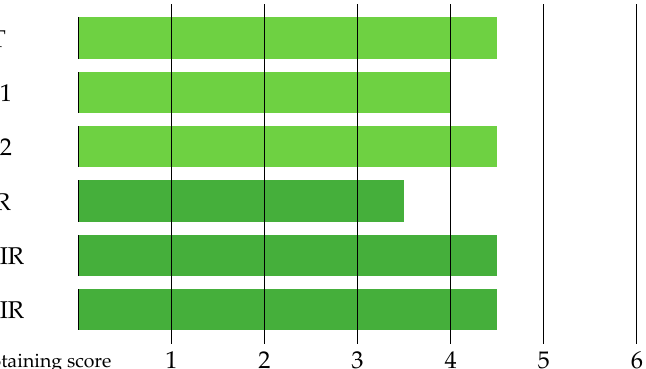
Figure 7. Scoring of the elastin immunostaining by microscopical examination on D6, on unex-